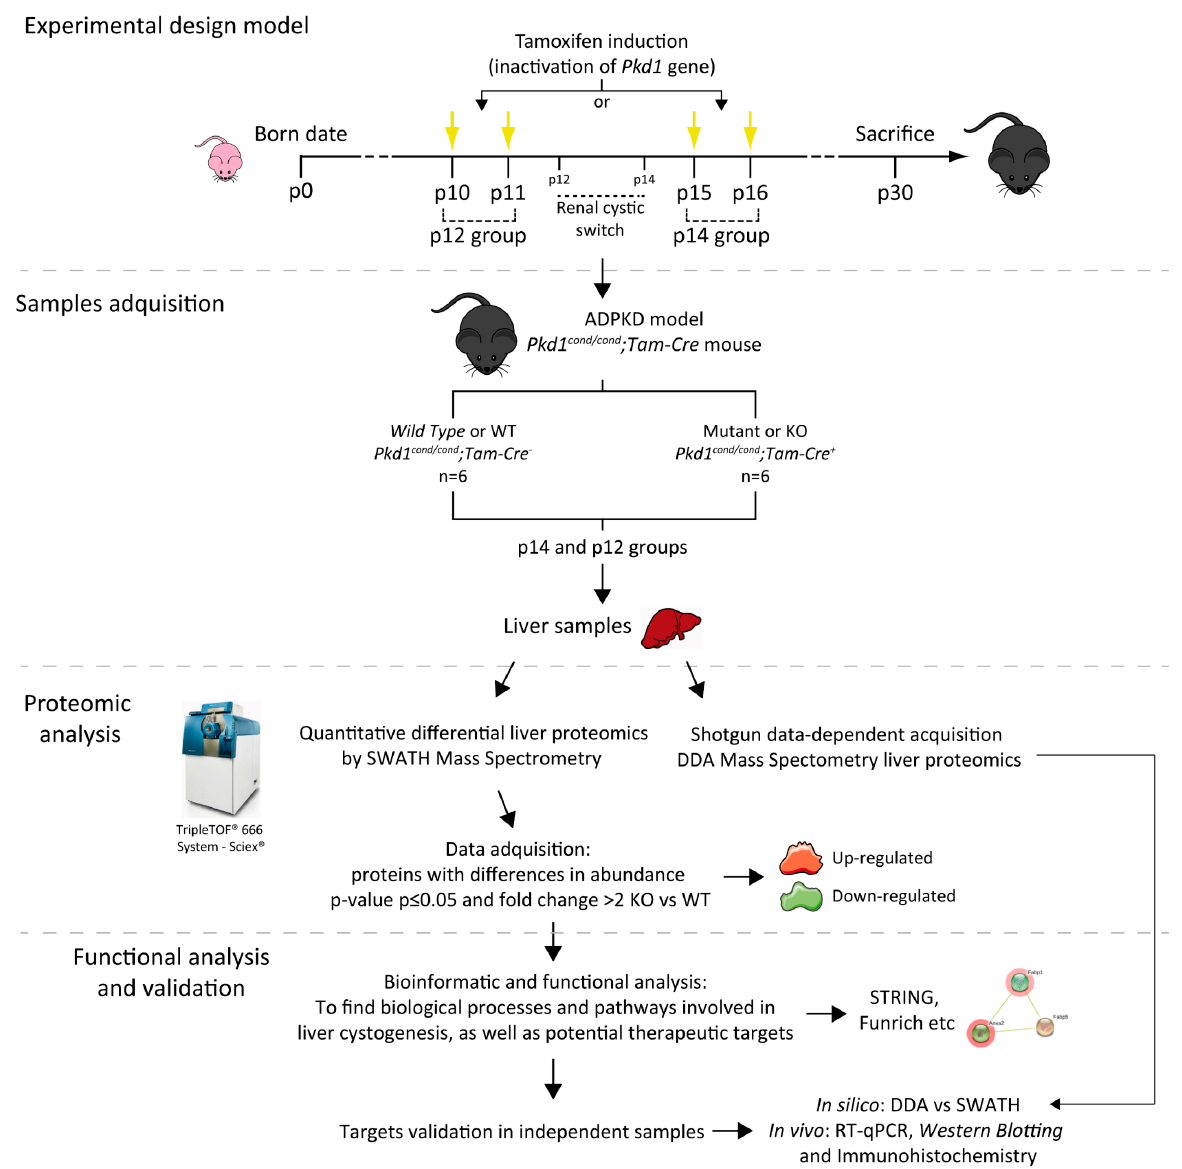
Figure 2. Illustrated workflow scheme. We used an ADPKD murine model ( Pkd1 cond/cond ;Tam ‐ Cre mice) in which the genetic inactivation of Pkd1 was induced by tamoxifen administration at postnatal day 10 (p10) and p11 (rapid disease progression) or p15 and p16 (delayed disease progression) according to the developmental switch for renal cystogenesis, defining the two groups of the study named p12 and p14 respectively [19]. For both groups, we used an n equal or greater than six Wild Type (WT) and Mutant (KO) individuals in each condition, and all animals were sacrificed at p30. We studied the differential proteome of WT and KO livers in both severities of liver cystic disease (Figure 1), using both quantitative proteomic SWATH–MS and shotgun data ‐ dependent acquisition DDA ‐ MS analysis. Of the proteins with a significant change in abundance, we used bioinformatics